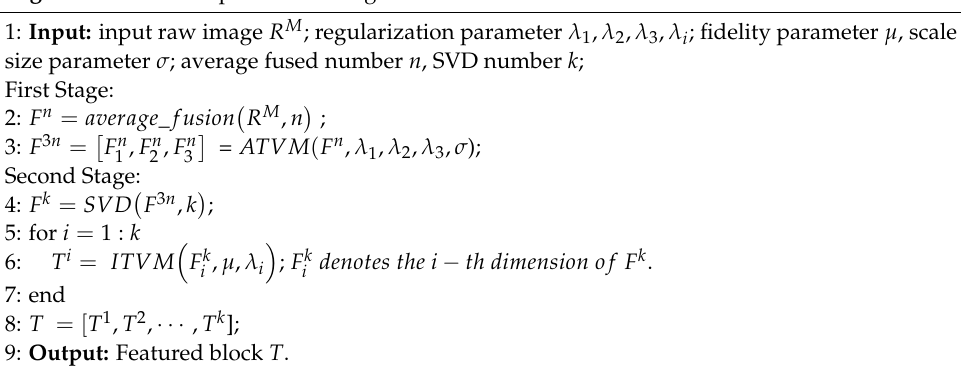
Algorithm 3: The Proposed Two-Staged FE Method